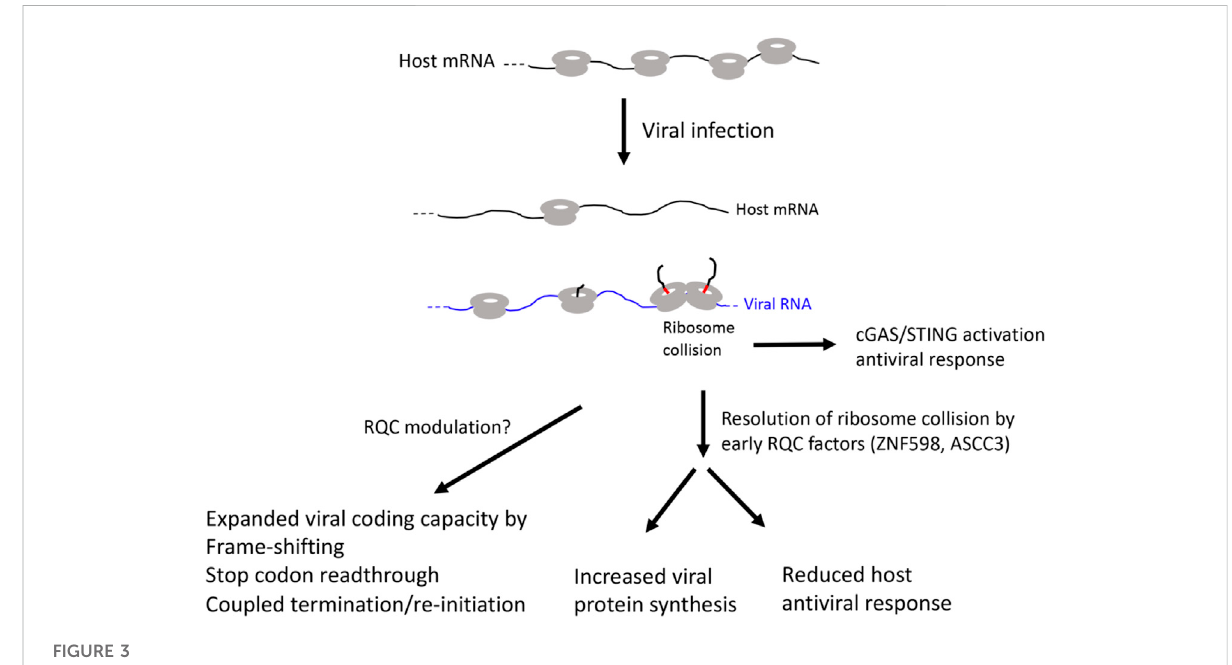
FIGURE 3 Diagram of possible RQC involvement in viral